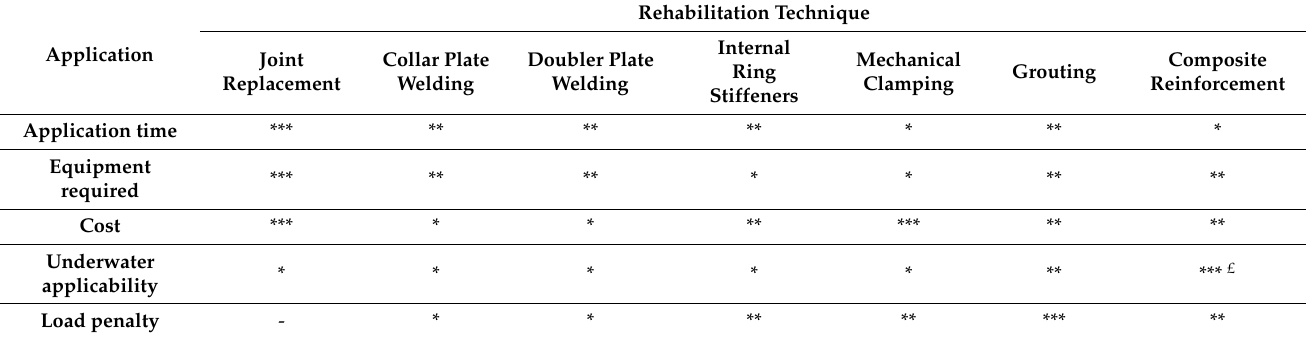
Table 3. Comparison of rehabilitation